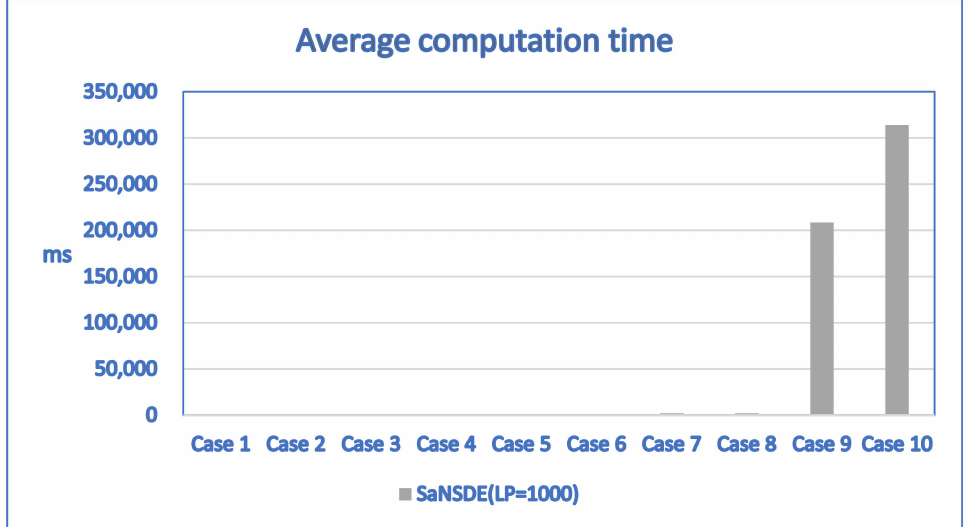
Figure 11. The average CPU time of SaNSDE with LP = 1000 for all